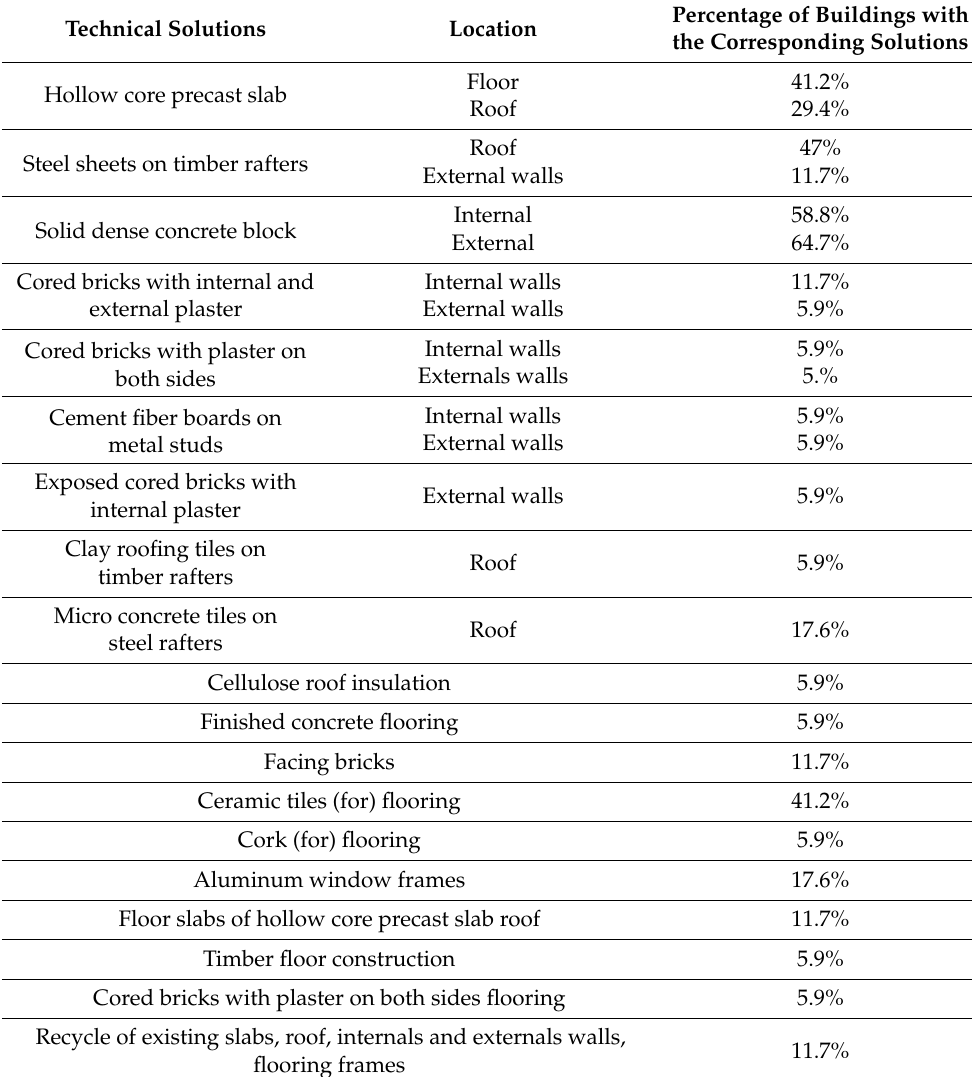
Table 7. Summarized materials-related technical solutions of the 17 residential complexes in South Africa with EDGE certification